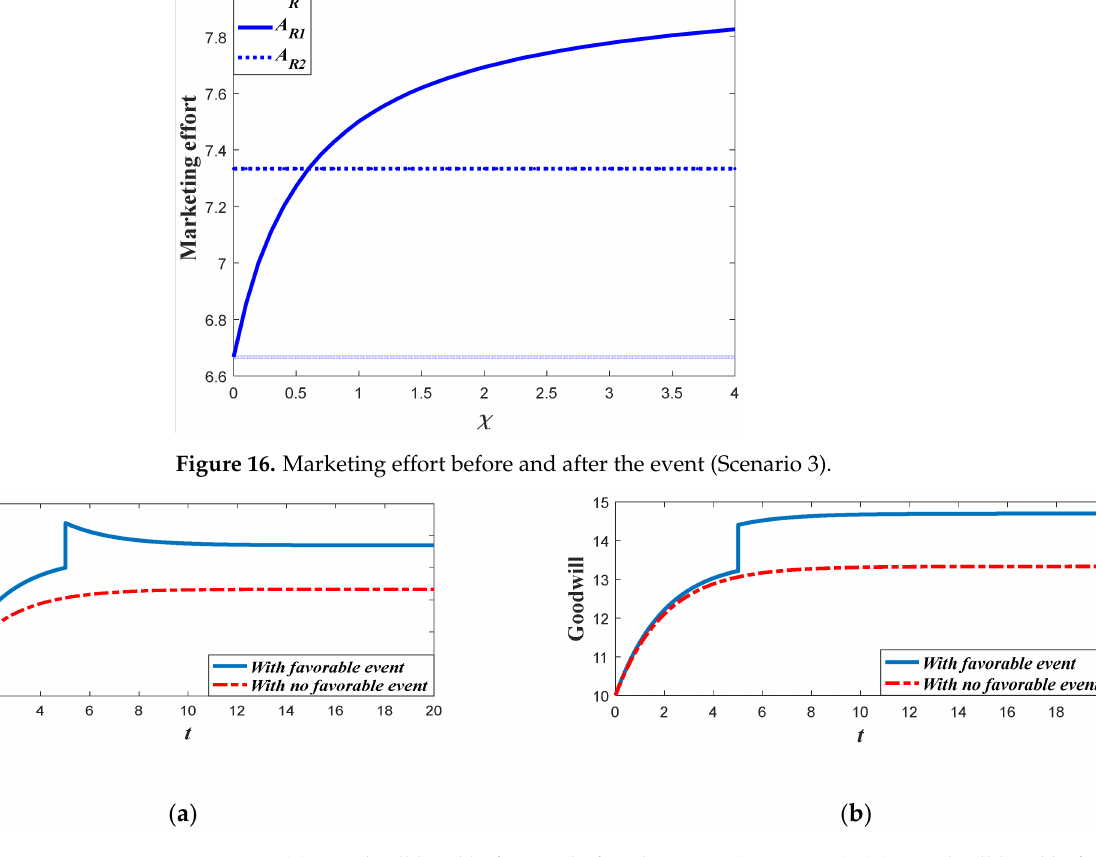
Figure 17. ( a ) Goodwill level before and after the event (Scenario 3). ( b ) Goodwill level before and after the event (Scenario